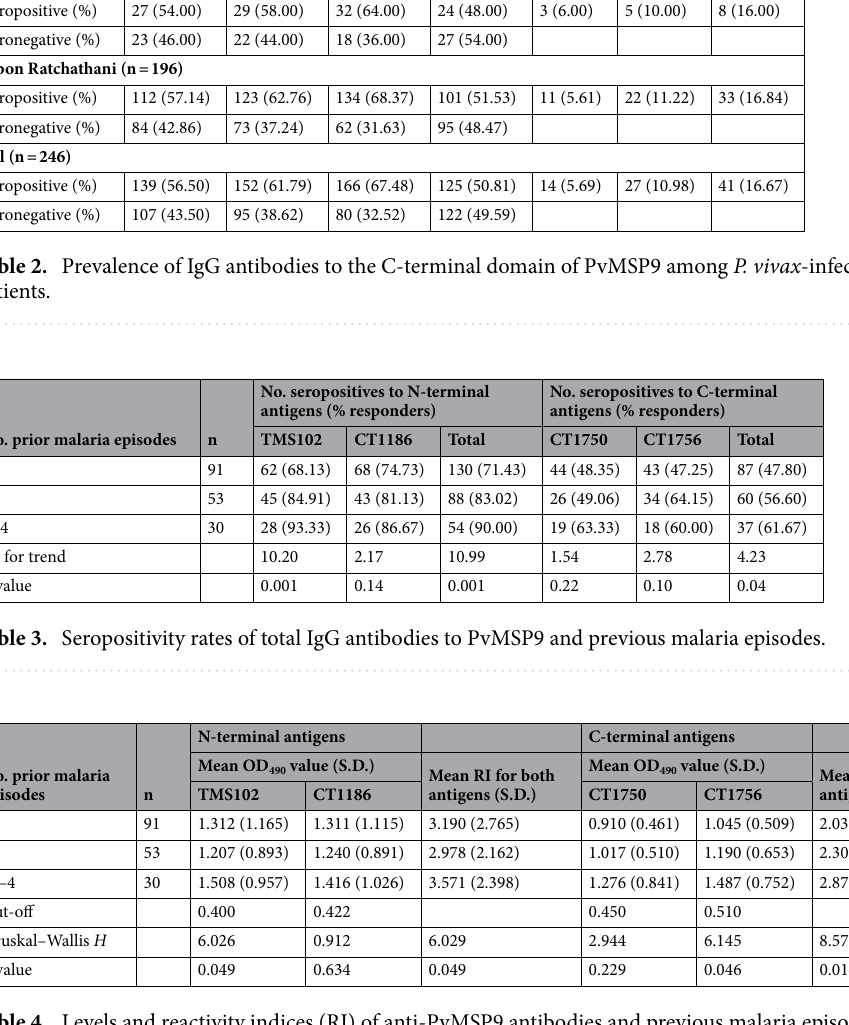
Table 4. Levels and reactivity indices (RI) of anti-PvMSP9 antibodies and previous malaria episodes.